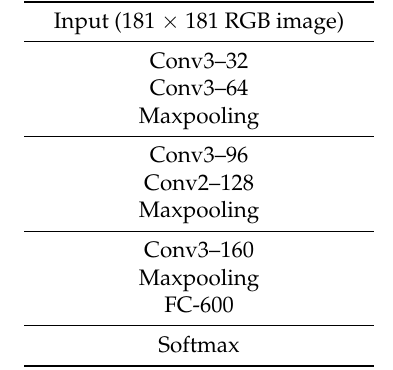
Table 1. The main CNN structure configuration adopted in SRSCNN.